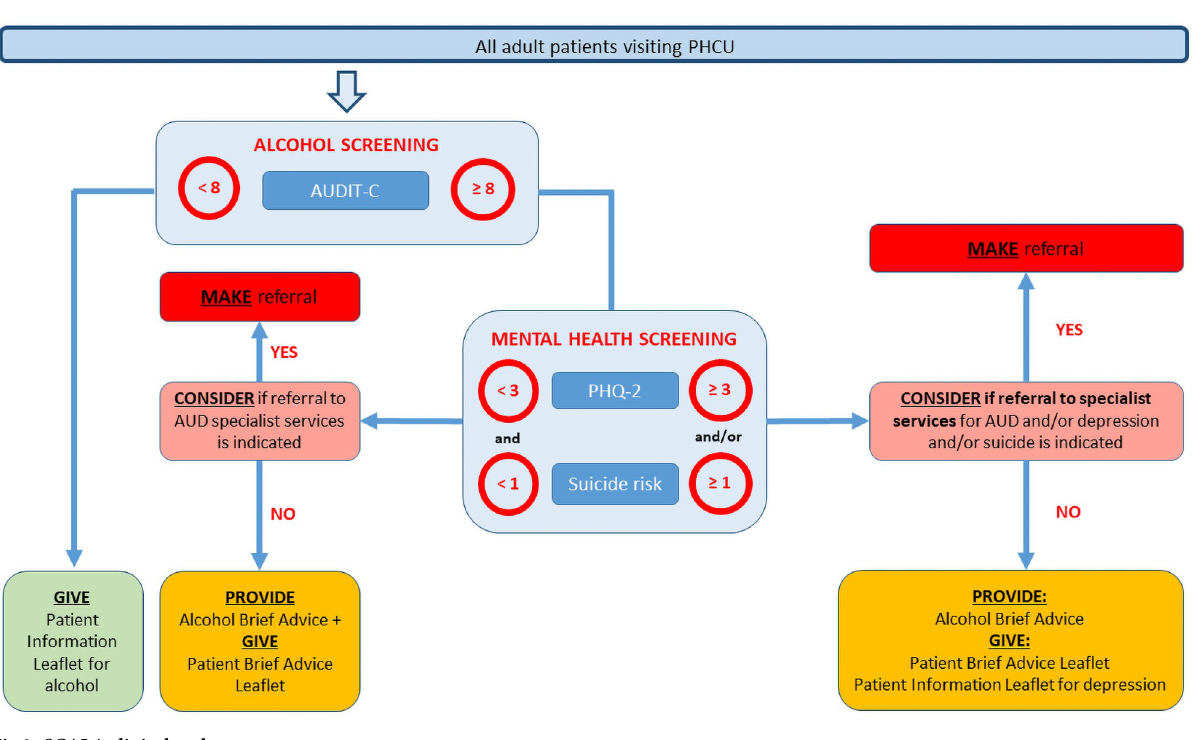
Fig 2. SCALA clinical